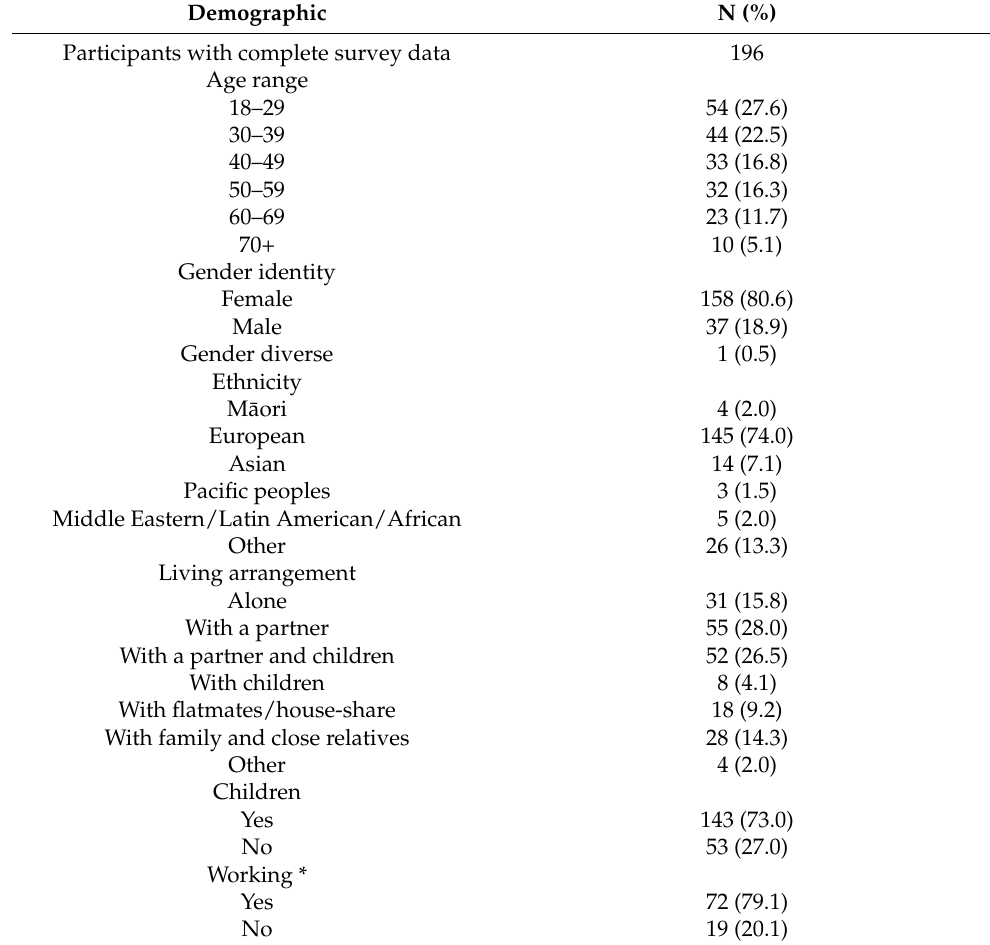
Table 1. Respondent